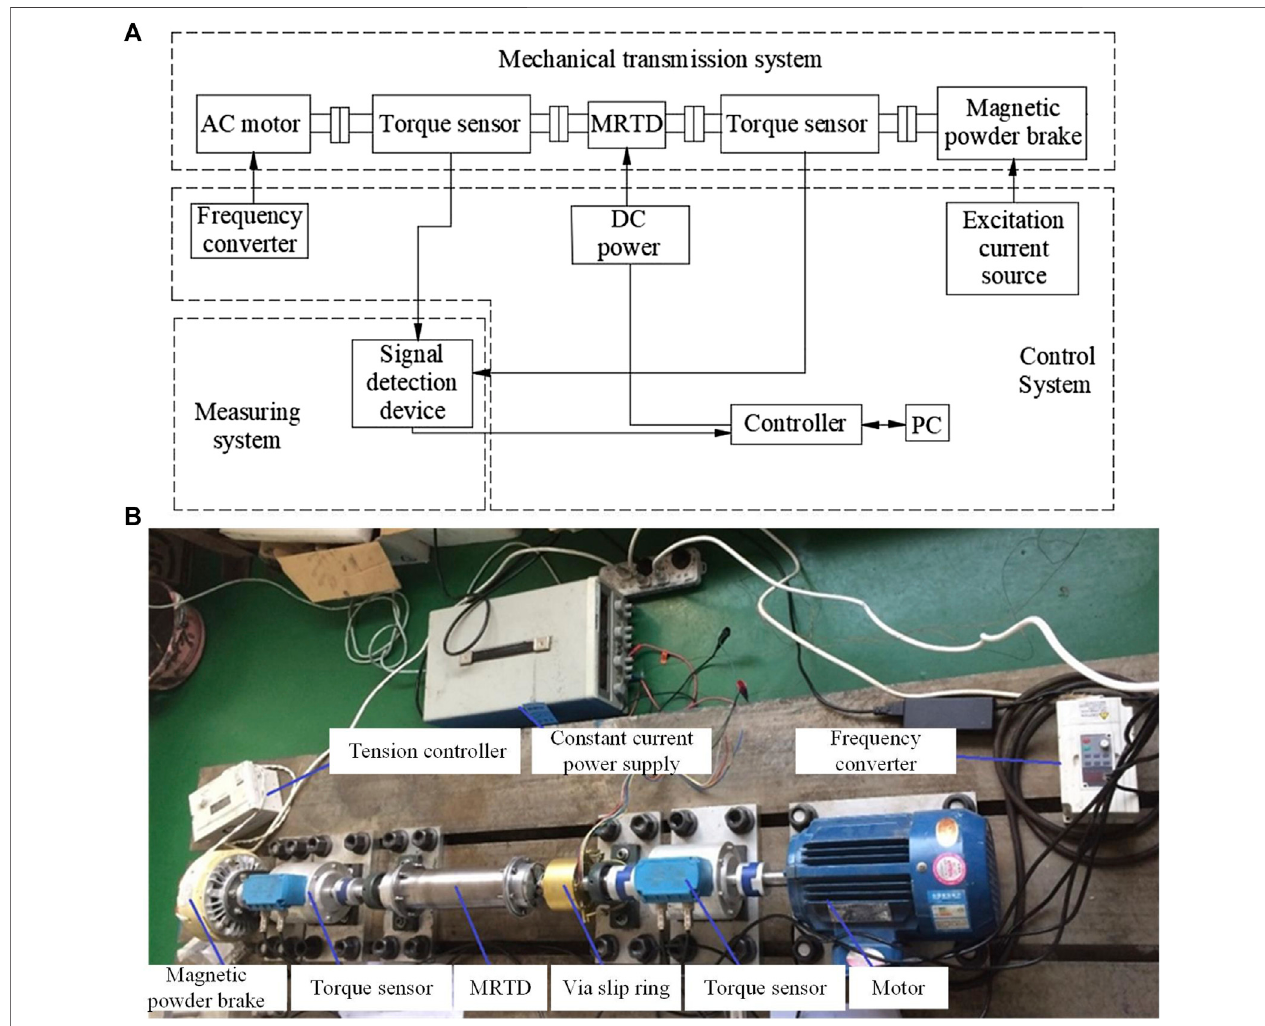
FIGURE 5 | Experimental system. (A) Functional component diagram and (B) image of the experimental system.